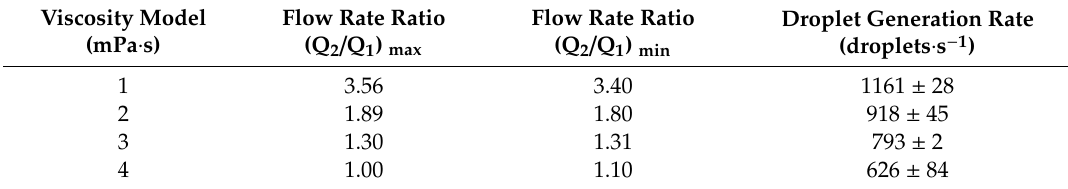
Table 1. Measured droplet generation rate for all tested viscosity models at a fixed centrifugal acceleration of 80 g (rcf reference point see Figure 1). For detailed mixture preparation see Section 4.4. The flow rate ratios (Q 2 / Q 1 ) max represent the case, where both inlets are filled completely; the ratios (Q 2 / Q 1 ) min represent the case where both inlets are empty (for detailed calculation see ESI 2, S1). The error represents the standard deviation of two independent measurements for each tested viscosity